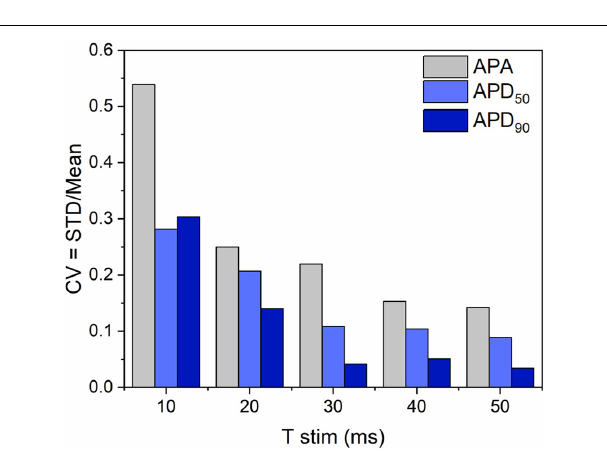
FIGURE 6 | Interwell variability of optogenetically induced APs. Interwell variability of APA and AP duration as a function of the light pulse duration. Upon increasing the optical stimulus from 10 to 50 ms, decreasing trends in the interwell variability of APA and AP duration (i.e., APD 50 and APD 90 ) were observed, confirming that differences in AP triggering due to non-uniform illumination can be overcome by stimulating with pulses ≥ 30